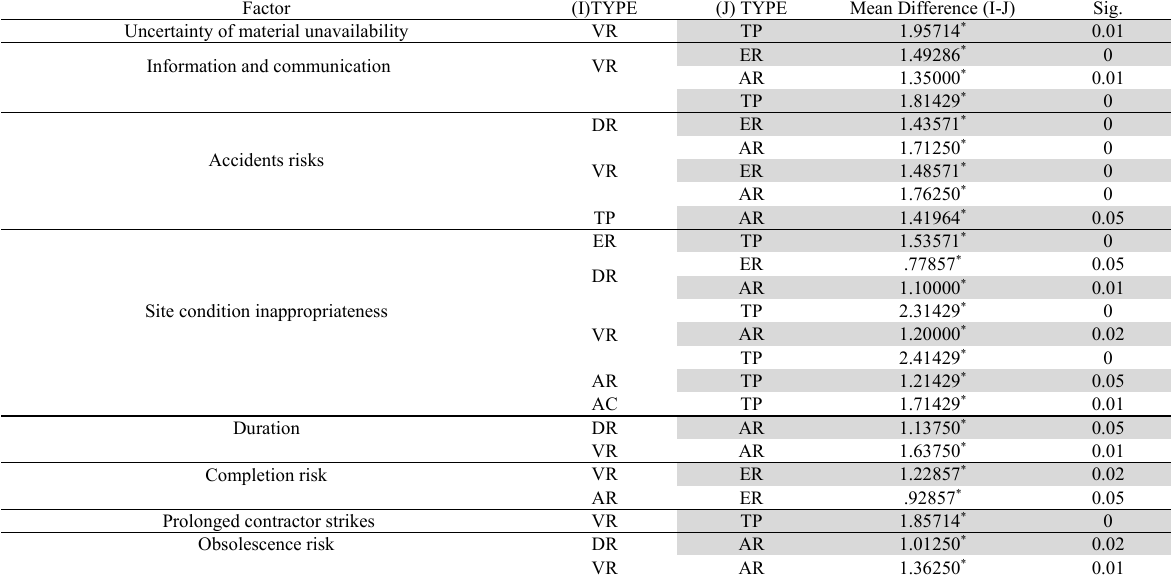
Post-Hoc (Tukey HSD)